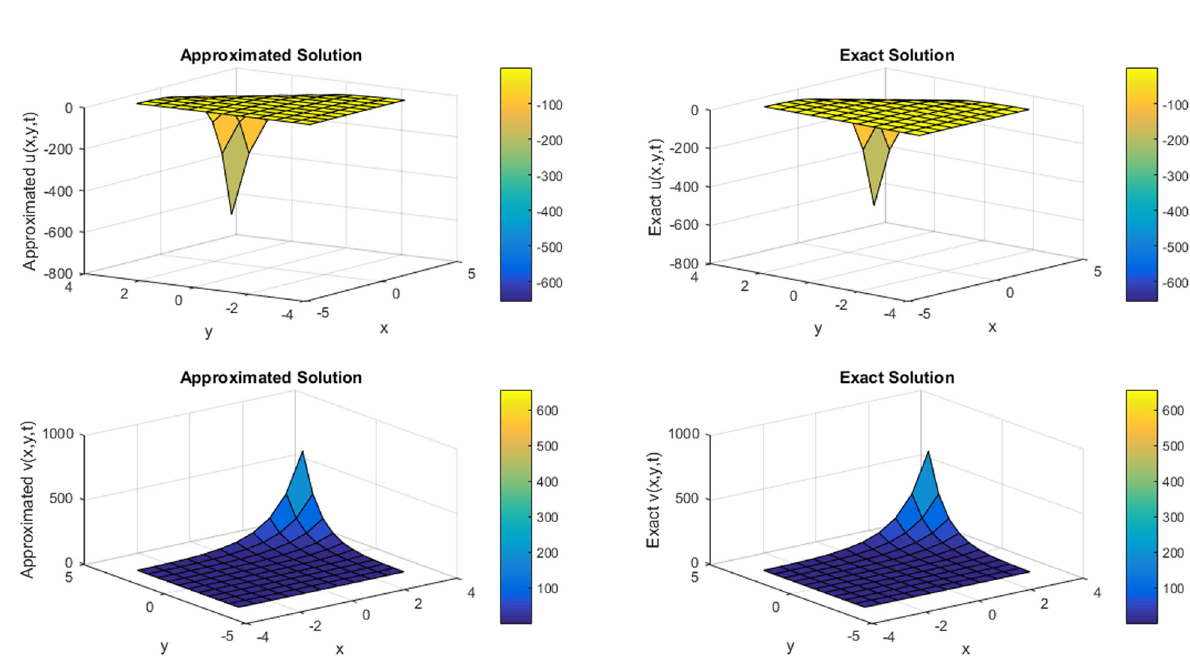
Figure 7: 3D plot for comparison of approximated and exact solutions at t = 1 with ρ = 0.1 and N = 11 for ϕ and ψ components regarding Example 4.